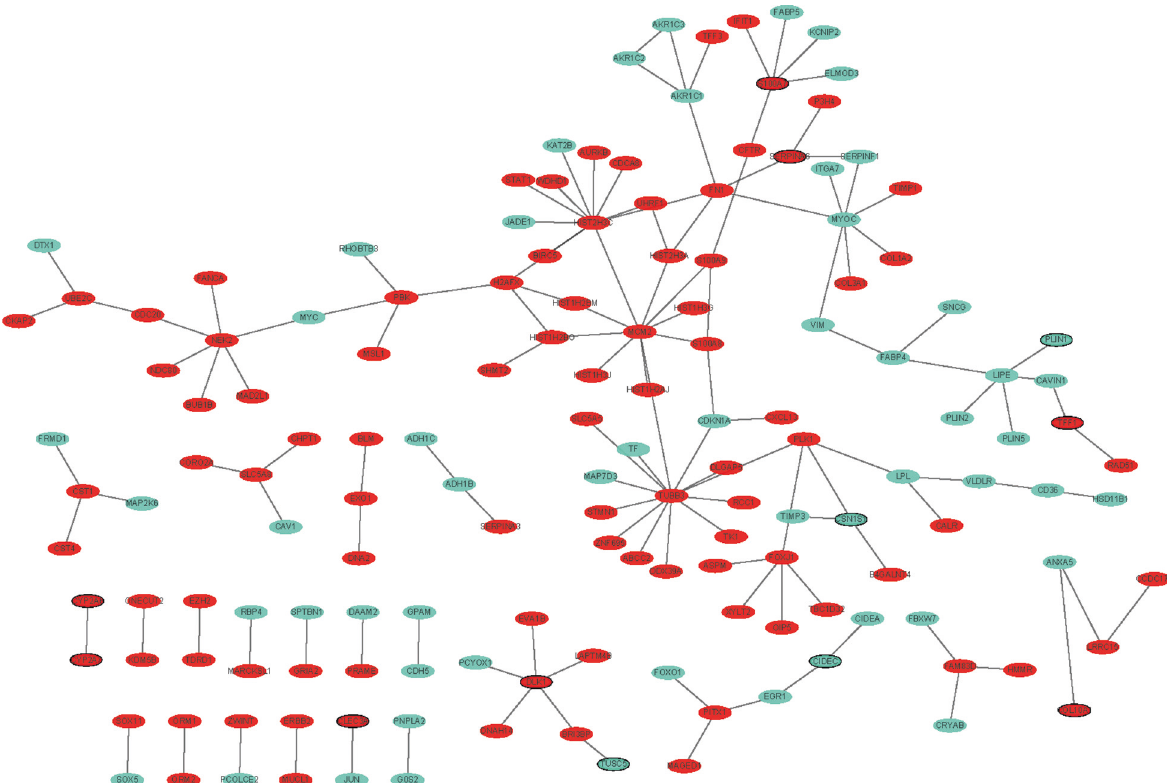
Figure 3: Luminal A breast cancer-specific PPI network. Ellipse and line are used to represent the node and edge, respectively. Red and green represent upward and downward adjustments, respectively. The black border indicates the top 10 upregulated and downregulated proteins.